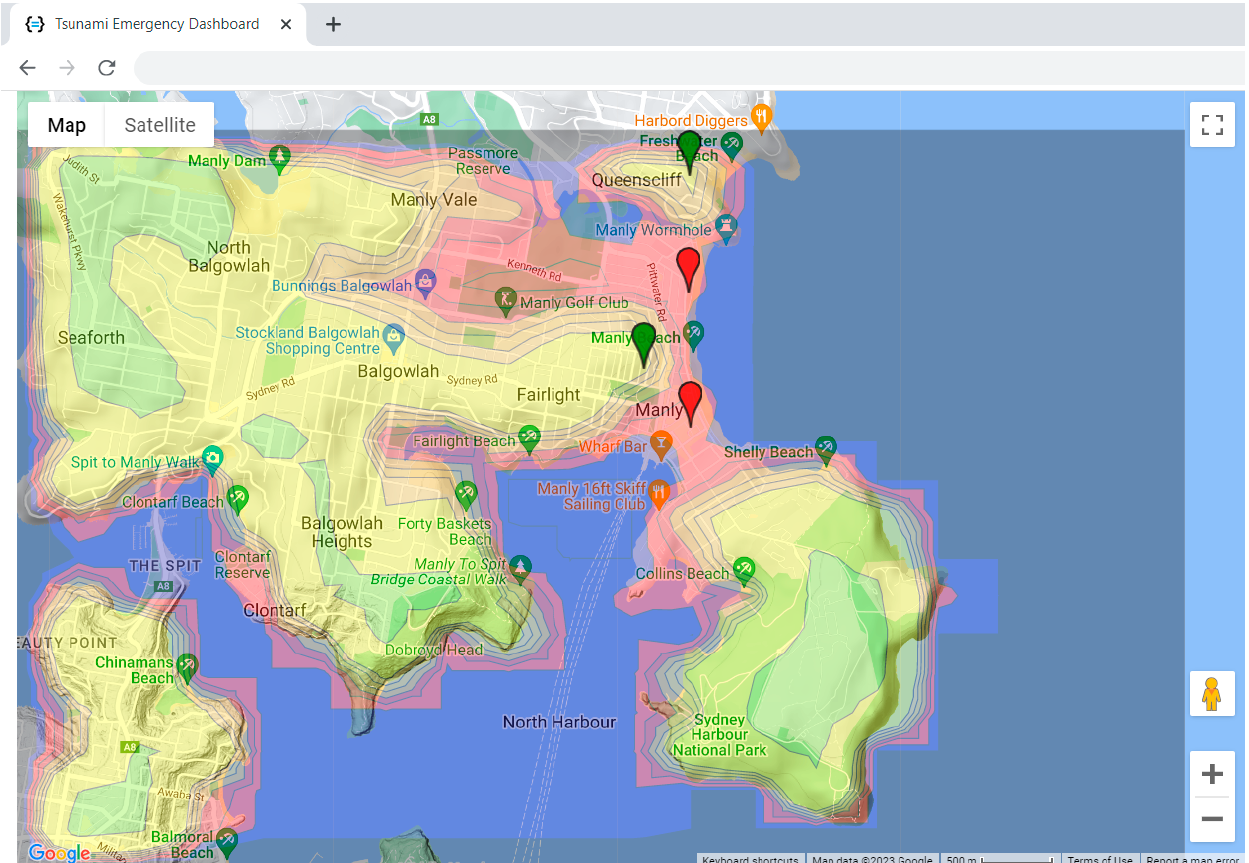
Figure 2. Map part of the tsunami emergency dashboard. The map is overlayed with contours. The contours are colour-coded from red through yellow to green. The red colour represents areas with the lowest elevation and highest tsunami risk. The green colour is used for places with the highest elevation and lowest tsunami risk. The location depicted is a Manly suburb in Sydney, Australia. The parameter setting controls (Figure 3) are used to specify locations and tsunami parameters. The particular locations are added and edited using the map control. The lo- cations can be identified and entered into the application prior to the simulations based